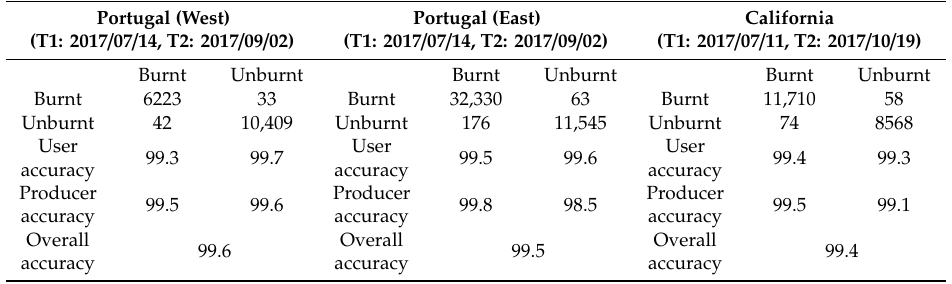
Table 4. Confusion matrices for Sentinel-2 scenes. Acquisition dates of pre- (T1) and post- (T2) fire images are